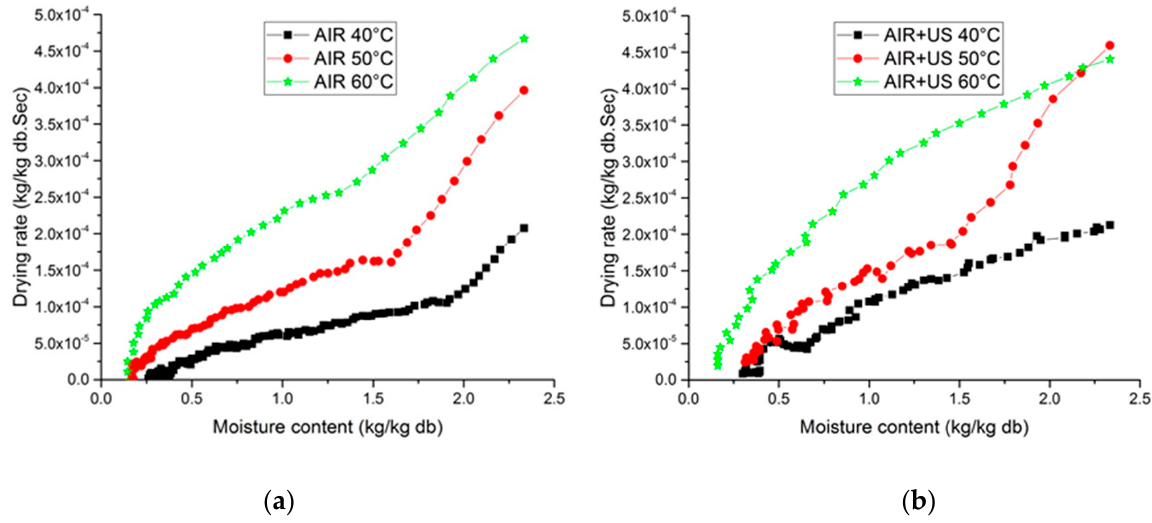
Figure 4. Drying rate curves of leaves henna vs. moisture content at different temperatures (40, 50 and 60 °C): ( a ) without ultrasound application (Air); and ( b ) with ultrasound application (Air + us; 20.5 kW/m 3 ; 21.7 kHz).